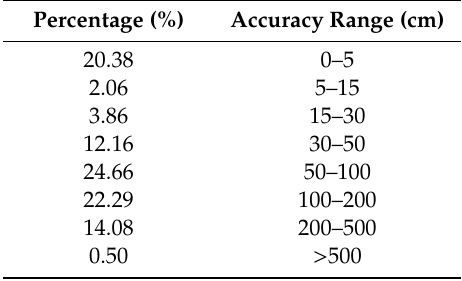
Table 1. Estimated horizontal accuracies, after post-processing, of the Global Navigation Satellite System (GNSS) points collected on highly vegetated Temwen